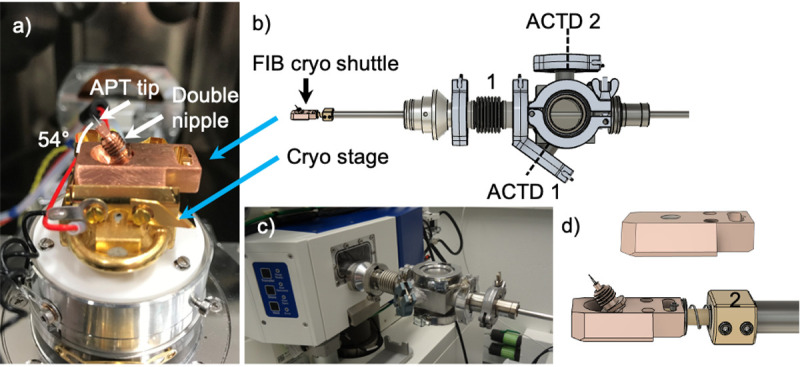
The cryo stage and FIB transfer device (FIBTD) enable characterization, sample preparation and transfer at cryogenic conditions.a) A custom 54° pre-tilted FIB cryo-shuttle mounted on the Quorum cryo-stage with key components and directions labeled. b) Rendered CAD drawing of the FIBTD indicating the flexible bellows coupling, 1, and the two possible connection points for the actively cooled transfer device (ACTD). c) The FIBTD connects directly to the existing FIB load-lock. d) The non-pre-tilted (top) and 54° pre-tilted FIB cryo-shuttles (bottom) attach to the end of the FIBTD with a bayonet connection and are thermally-isolated from the transfer rod with a polyether ether ketone end-component, 2.